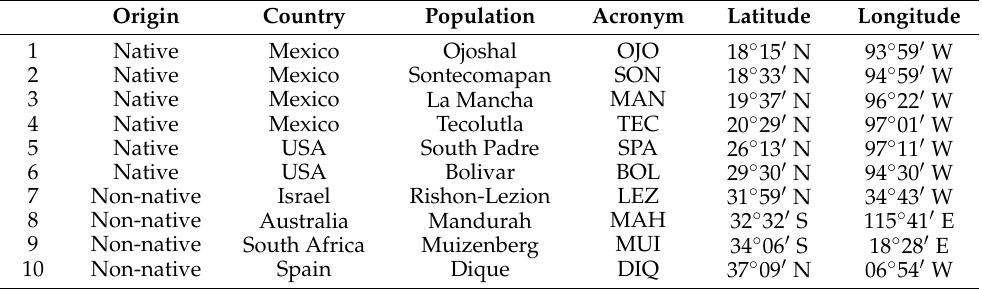
Table A1. Geographic location of native and non-native populations of Oenothera drummondii studied. Numbers corresponding with geographic location in Figure